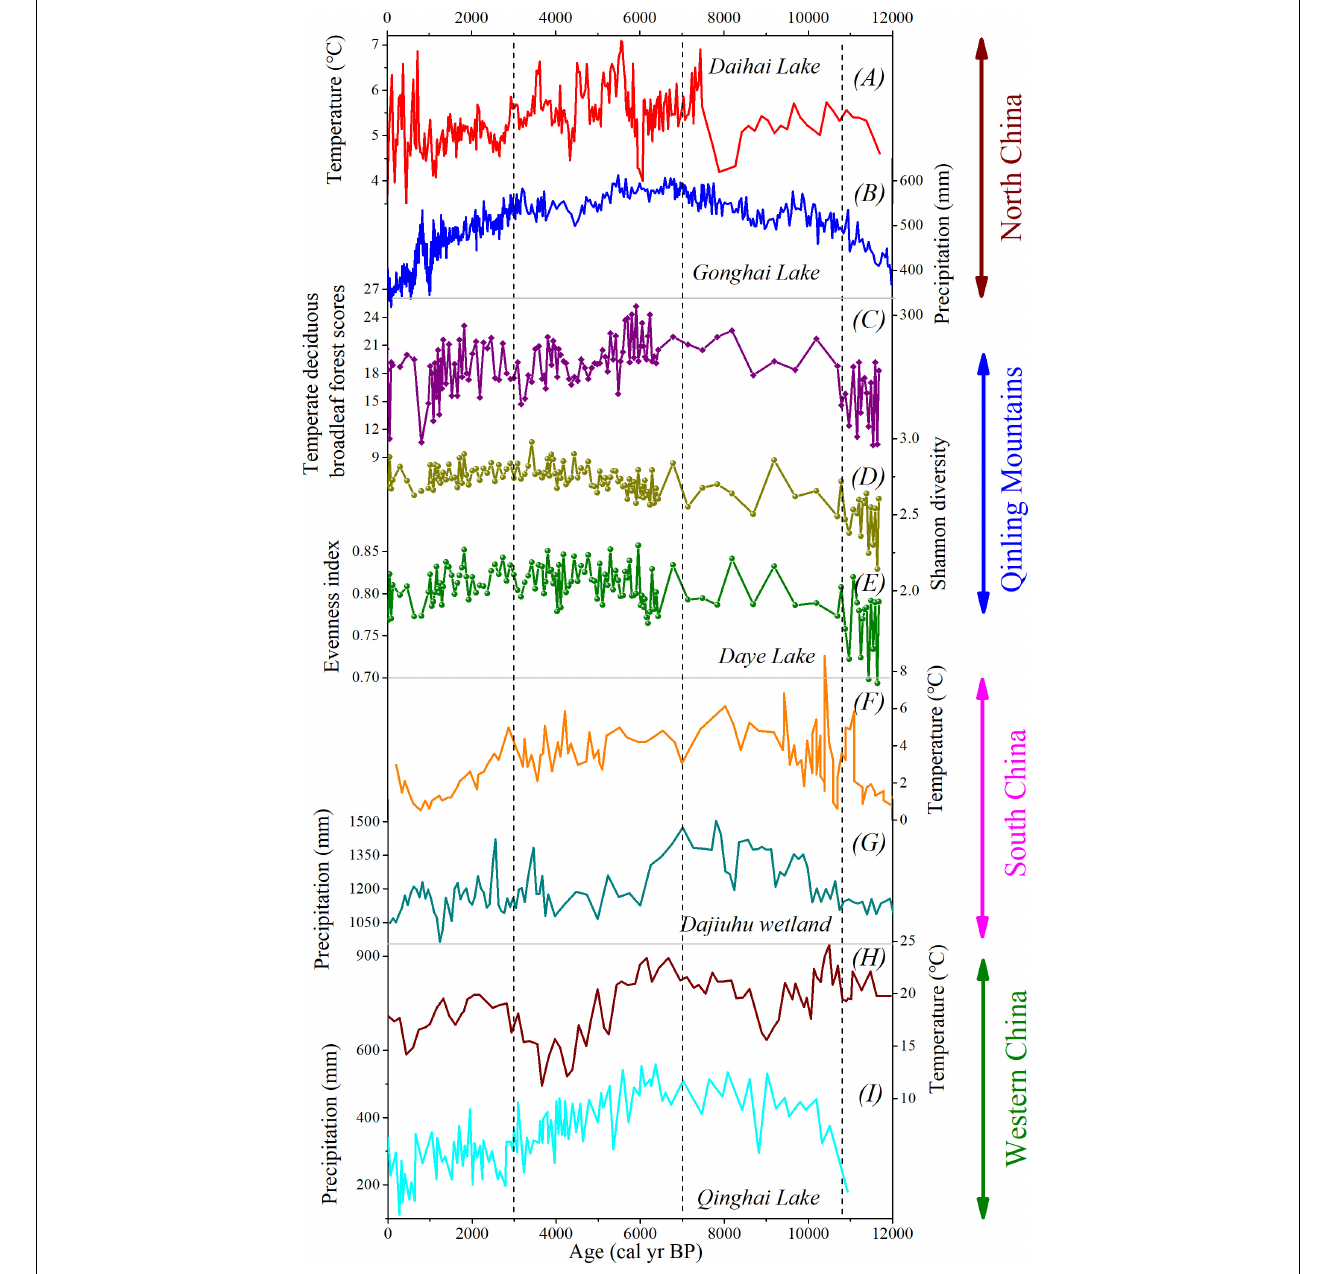
FIGURE 6 | Comparison of vegetation changes in the Qinling Mountains region with paleoclimatic records from other sites in China. (A) Pollen-based temperature reconstruction from Daihai Lake (Xu et al., 2010). (B) Pollen–based precipitation reconstruction from Gonghai Lake (Chen F. H. et al., 2015). (C) Temperate deciduous broadleaf forest scores based on the biome reconstruction from Daye Lake. (D) Shannon index of palynological diversity from Daye Lake. (E) Evenness index from Daye Lake. (F) Temperature reconstruction based on the branched fatty alcohol ratio BNA 15 from the Dajiuhu wetland (Huang et al., 2013). (G) Pollen-based precipitation reconstruction from the Dajiuhu wetland (Sun et al., 2019). (H) U K 37 -inferred temperature record from Qinghai Lake (Hou et al., 2016). (I) Pollen-based precipitation reconstruction from Qinghai Lake (Herzschuh et al., 2010).